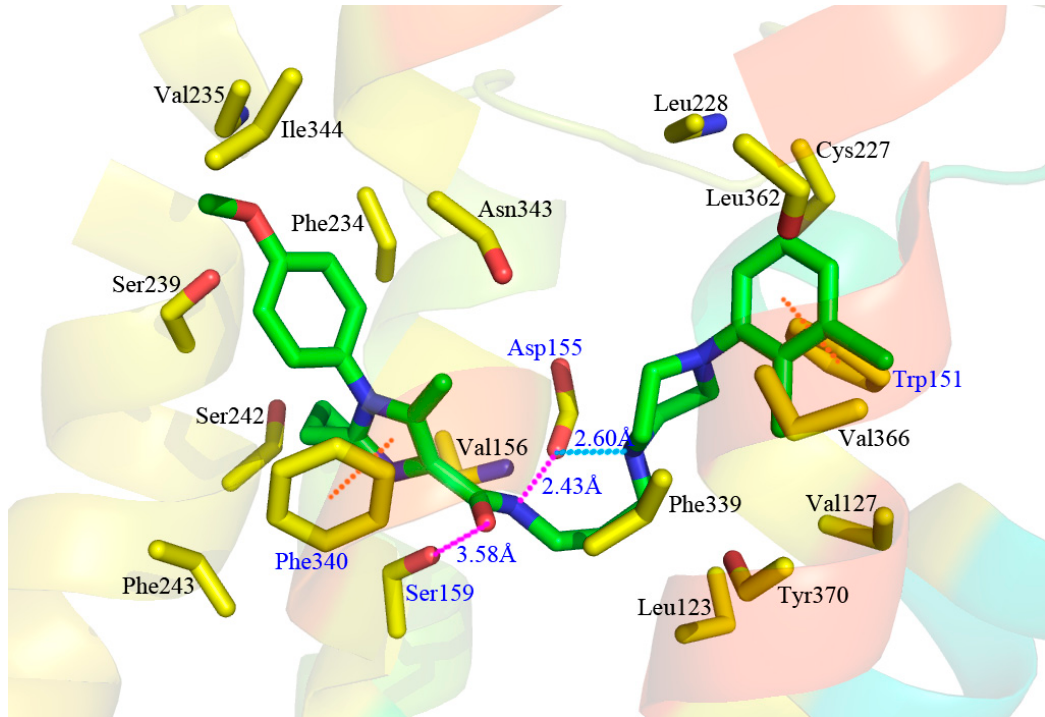
Figure 7. Compound 13 and the interaction groups of the key amino acids are shown in sticks and highlighted with green and yellow carbons, respectively. N-atoms, O-atoms and S-atoms are colored blue, red and yellow, respectively. H-bond, π - π stacking and electronic interactions are shown as purple, orange and azure dashed lines, respectively.